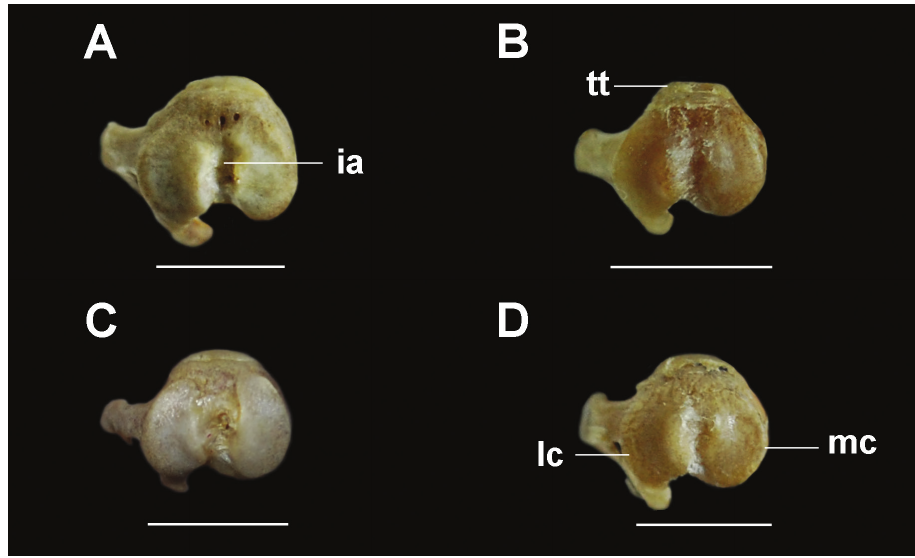
Figure 7. Proximal view of the tibia. A Tympanoctomys aureus B Tympanoctomys barrerae C Tympanoc- tomys kirchnerorum D Tympanoctomys loschalchalerosorum . a, intercondylar area; lc, lateral condyle; mc, medial condyle; tt, tibial tuberosity. Scale bars